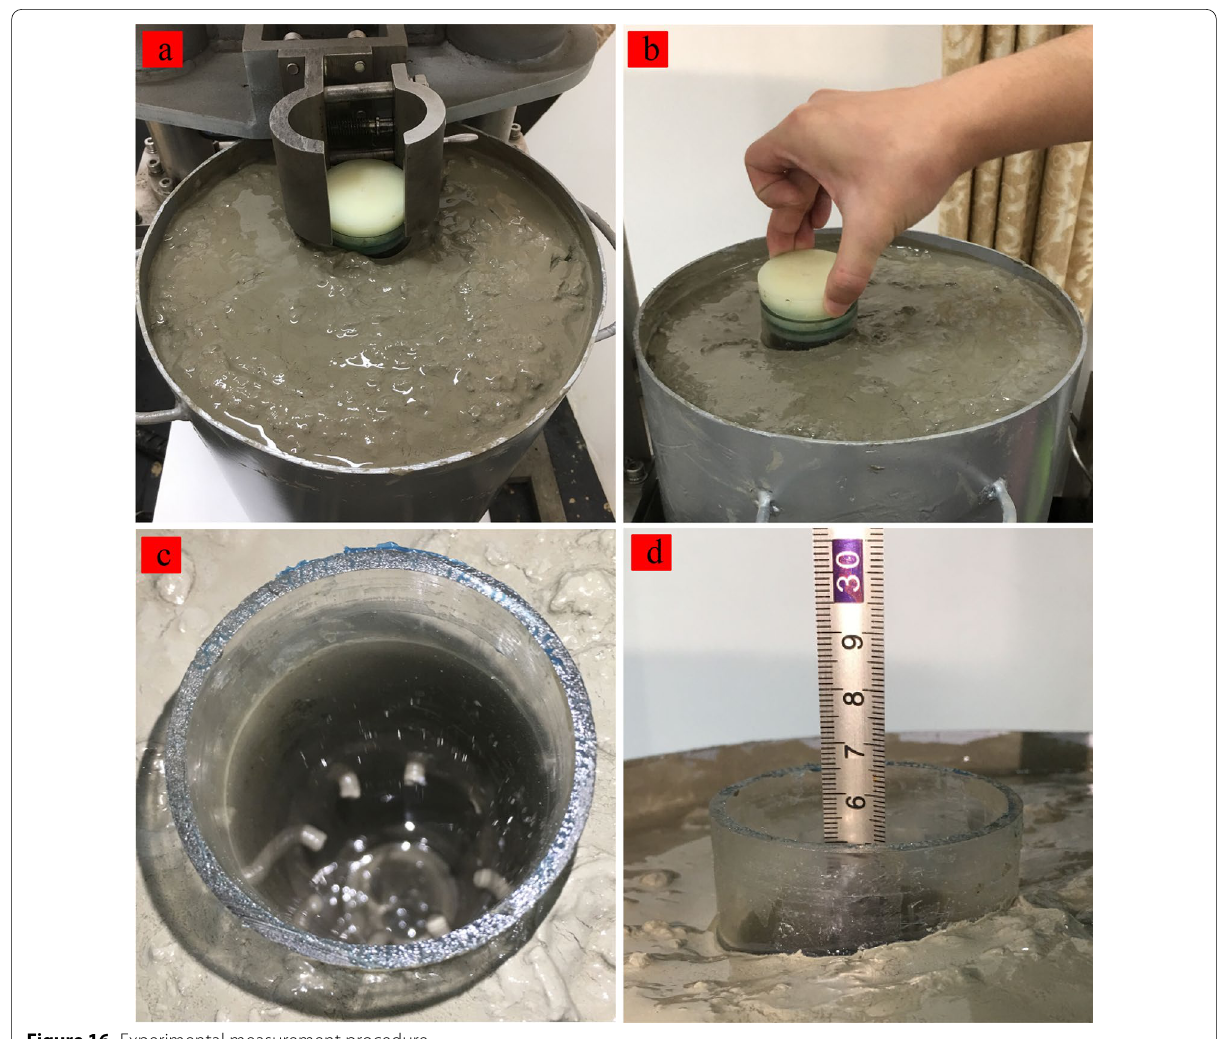
Figure 16 Experimental measurement